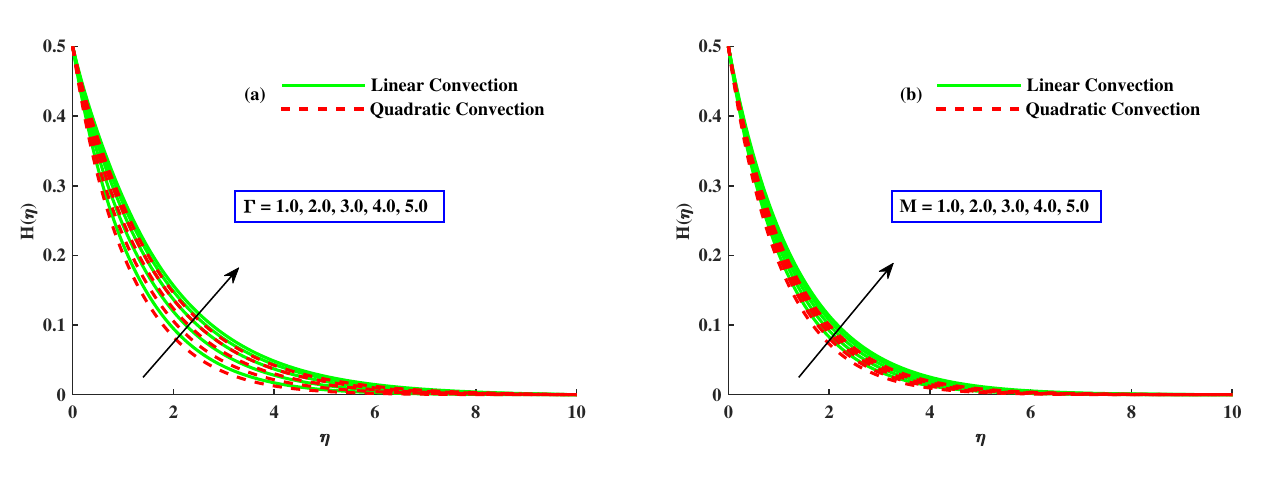
Figure 6. The influence of Γ & M on the H ( η ) .